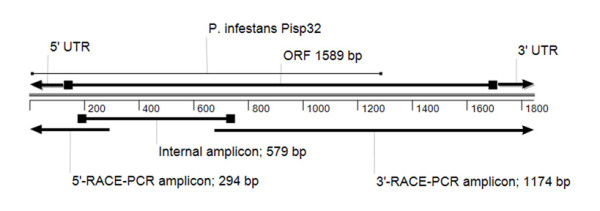
Scheme of PCR experiments. The alignment shows the three amplicons, which led to the ORF and untranslated regions (UTRs) of the 57 kDa protein of P. halstedii. The internal amplicon was revealed with the primer pairs F1+R1 and F2 + R2 (nested PCR). The 3'-RACE-PCR amplicon was revealed with the gene-specific primer PhE-F1 and PhE-F2 (semi-nested PCR). The 5'-RACE-PCR amplicon was revealed with the gene-specific primer PhE-R1, PhE-R2 (semi-nested PCR) and PhE-R3 (semi-nested PCR). In all RACE experiments the provided adaptor primer of the SMART™ RACE cDNA amplification kit was used.